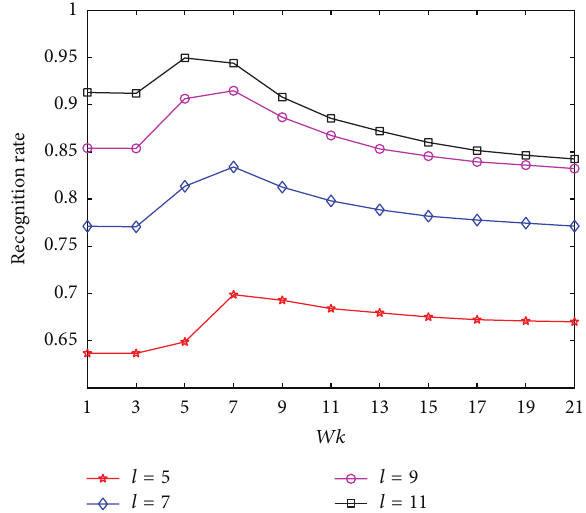
Figure 5: The average recognition rates of MNMDP versus 𝑊𝑘 on FKP.